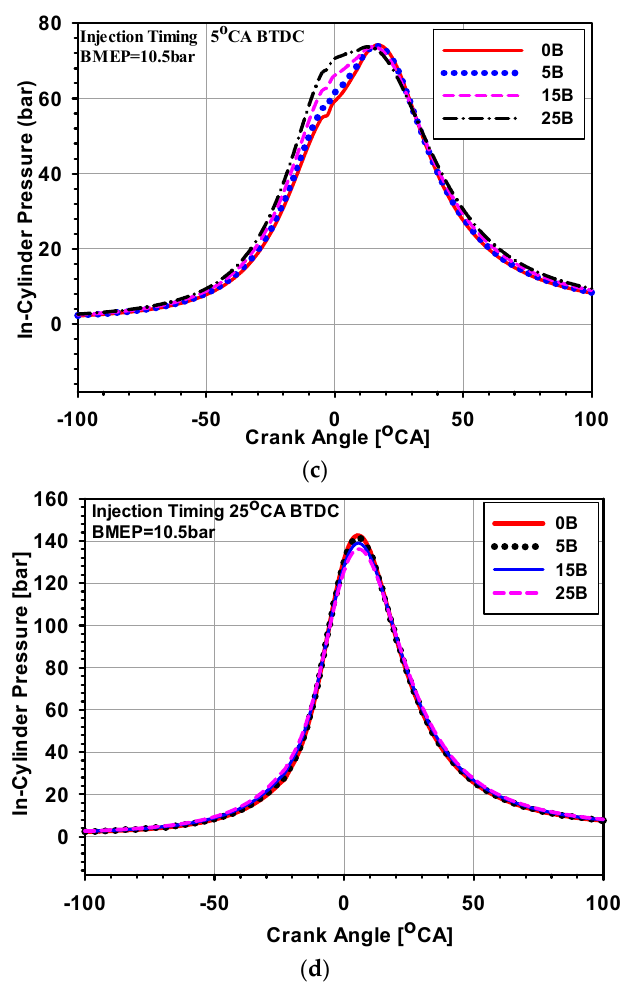
Figure 3. Variation of in-cylinder pressure: ( a ) BMEP 4.5 bar, injection timing 5 ° CA bTDC; ( b ) BMEP 4.5 bar, injection timing 25 ° CA bTDC; ( c ) BMEP 10.5 bar, injection timing 5 ° CA bTDC; and ( d ) BMEP 10.5 bar, injection timing 25 ° CA bTDC.